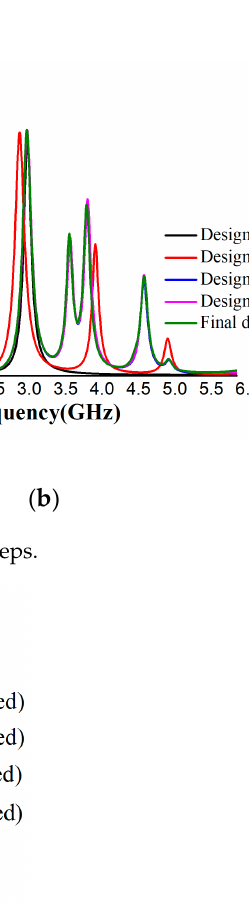
Figure 2. The designed unit cell. ( a ) Fabricated. ( b ) Measured by VNA.